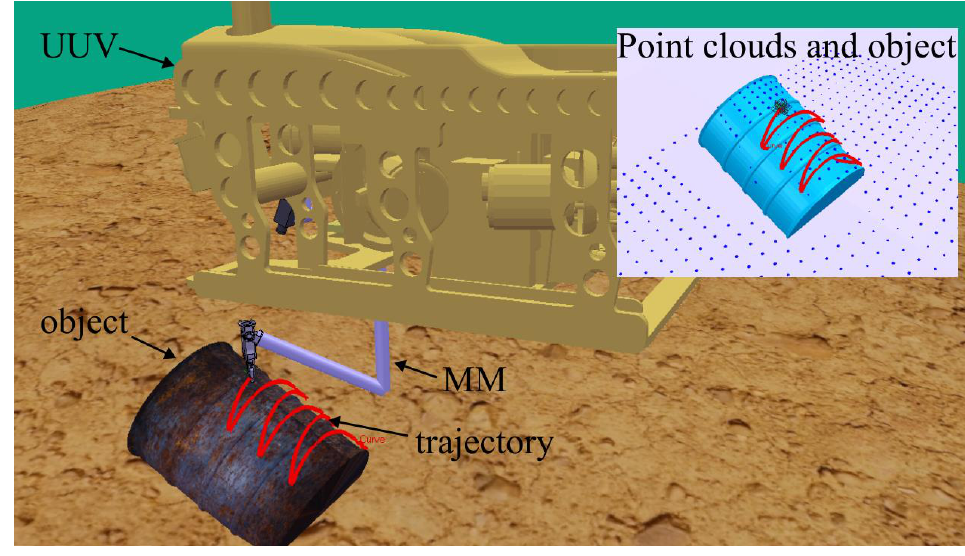
Figure 7. A scene in the V-REP simulator. Table 1. Parameters of UUV and